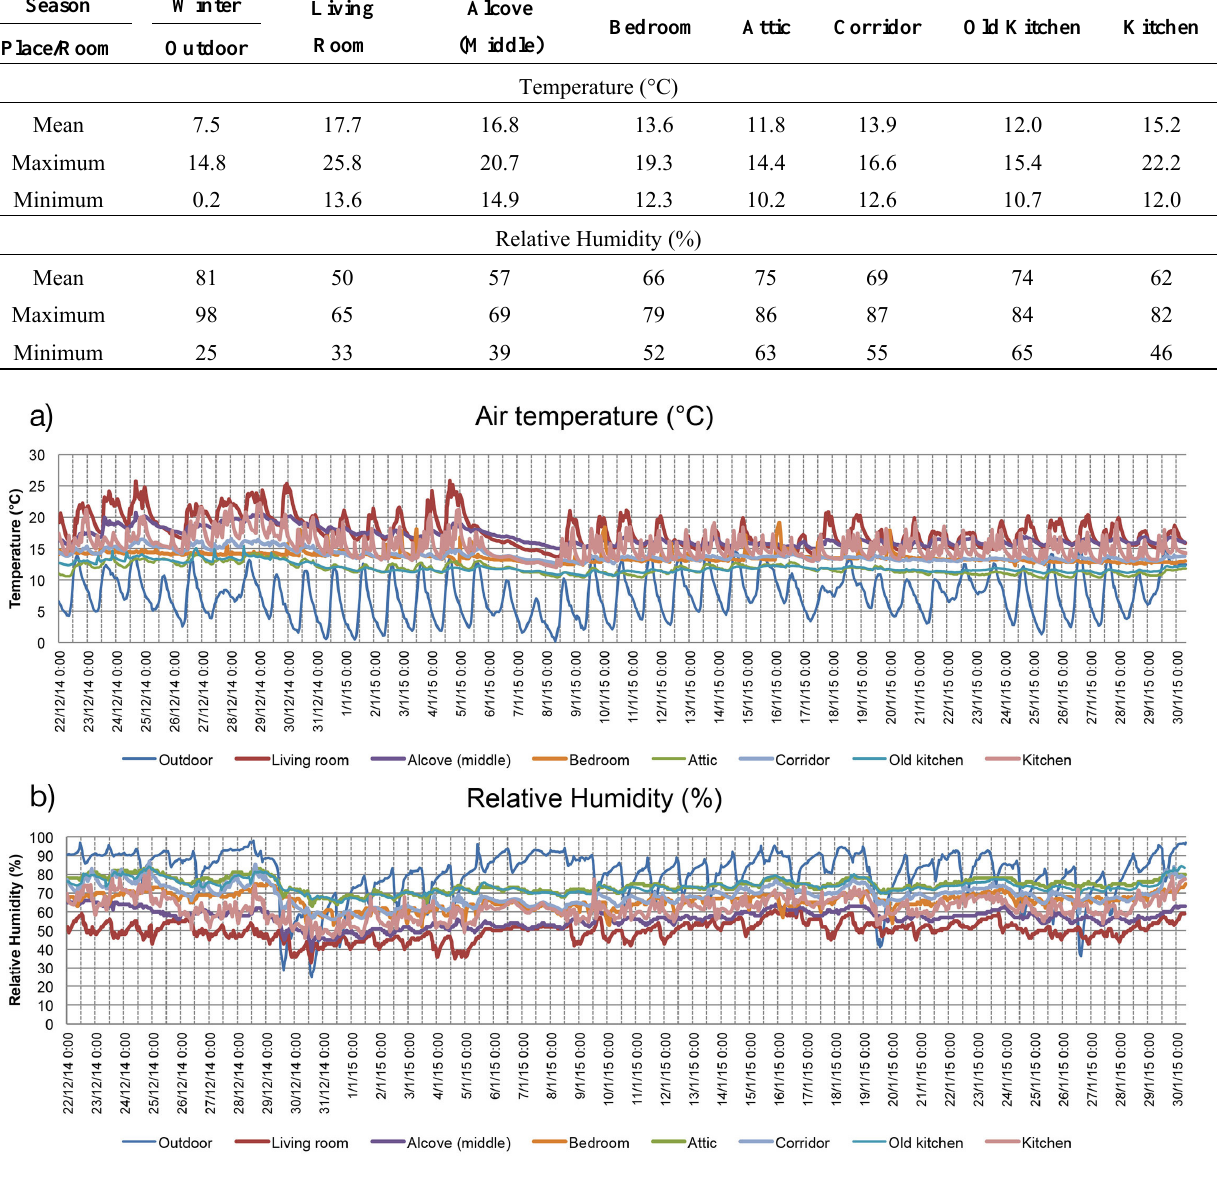
Figure 14. Case study 2 performance during winter season. ( a ) Indoor and outdoor air temperature profile; ( b ) Indoor and outdoor relative humidity